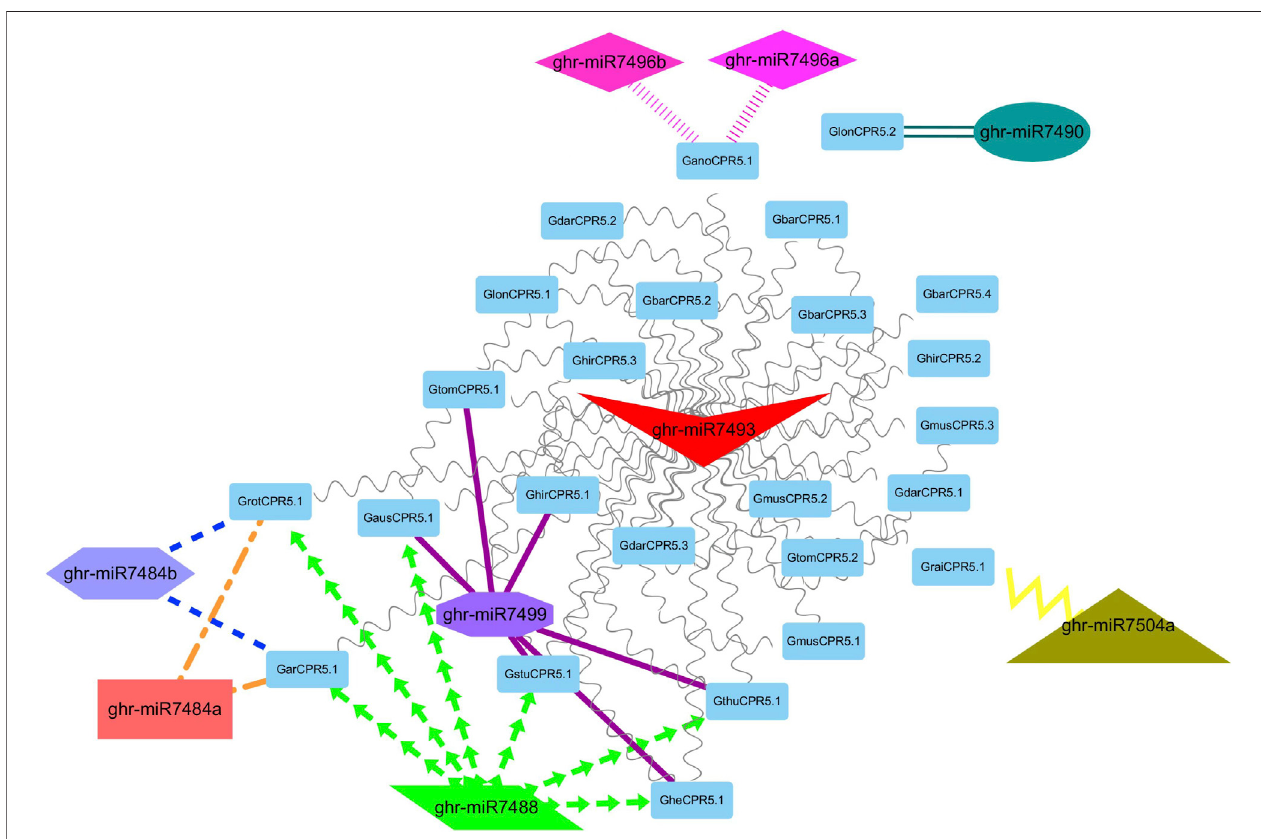
FIGURE 7 | A network representation of the regulatory connections among the predicted miRNAs and Gossypium CPR5 genes. Different colors highlight the interacting miRNAs. Similarly, different node colors and shapes clearly represent the interaction among miRNAs and Gossypium CPR5 genes.